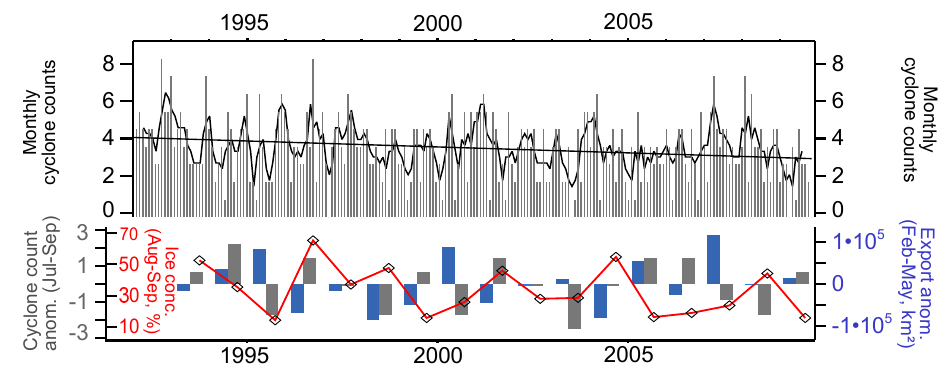
Fig. 13. The upper panel shows the frequency of cyclone counts per month in the Laptev Sea for the period between 1992 and 2009. The black lines represent the 3 month running mean and the trend. The lower panel presents anomalies in cyclone counts entering the Laptev Sea from the south and west between July and September (grey bar, left axis). The red line shows the average sea ice concentration for August - September (second left axis). Blue bars refer to anomalies in ice area flux out of the Laptev Sea across the NB and EB between February and May (given in km 2 , right axis).